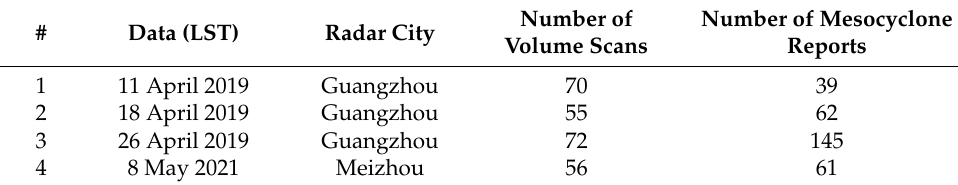
Table 2. The four mesocyclonic hailstorm events and mesocyclone reports.